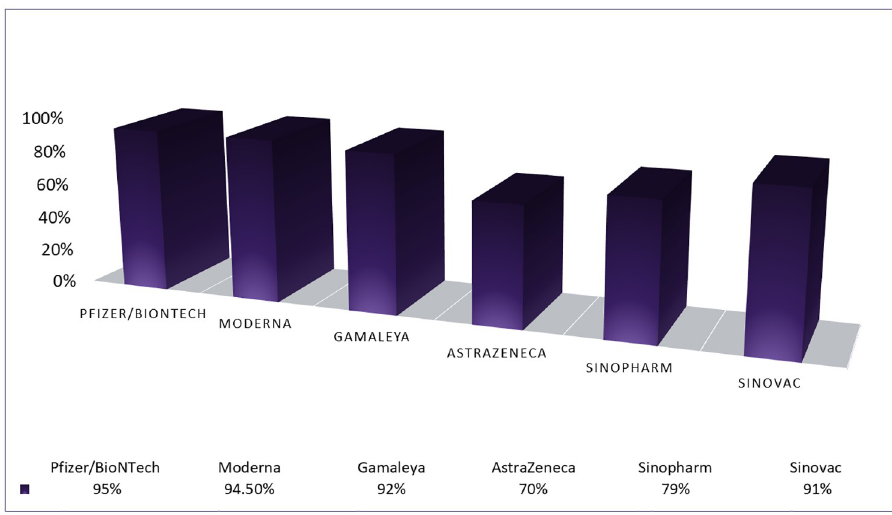
Fig 1. Vaccines and reported efficacy for